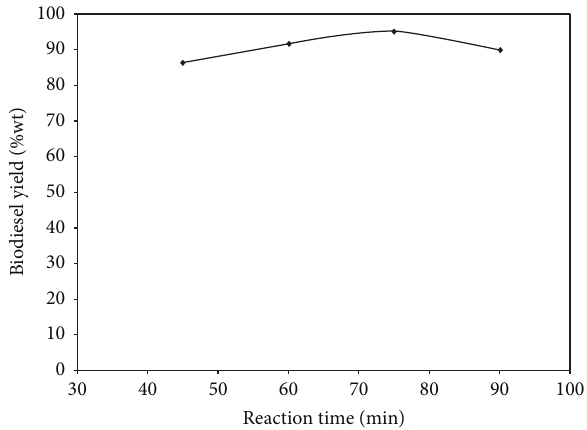
Figure 4: Effect of reaction time on biodiesel yield (molar ratio of 6 :1, reaction temperature of 60 ∘ C, and catalyst concentration of 0.5 w/w %).